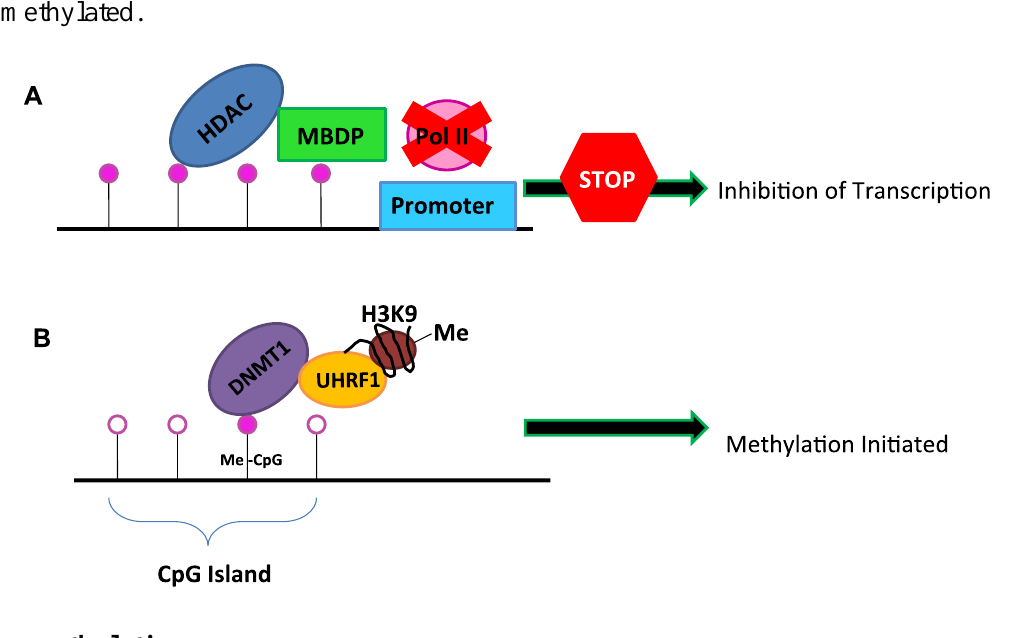
Figure 2. ( A ) Model of inhibition of transcription by methylation of CpG islands in gene promoter regions. HDAC: histone deacetylases; MBDP: methyl binding domain protein; Pol II: RNA polymerase II; and ( B ) Model linking histone methylation with DNA CpG methylation. DNMT1: DNA methyltransferase I; Me-CpG: methylated CpG residue; UHRF1: ubiquitin-like protein containing PHD and RING domains 1; H3K9: histone 3 lysine 9; Me: methylated. Open circles indicate unmethylated CpG residues; closed circles are